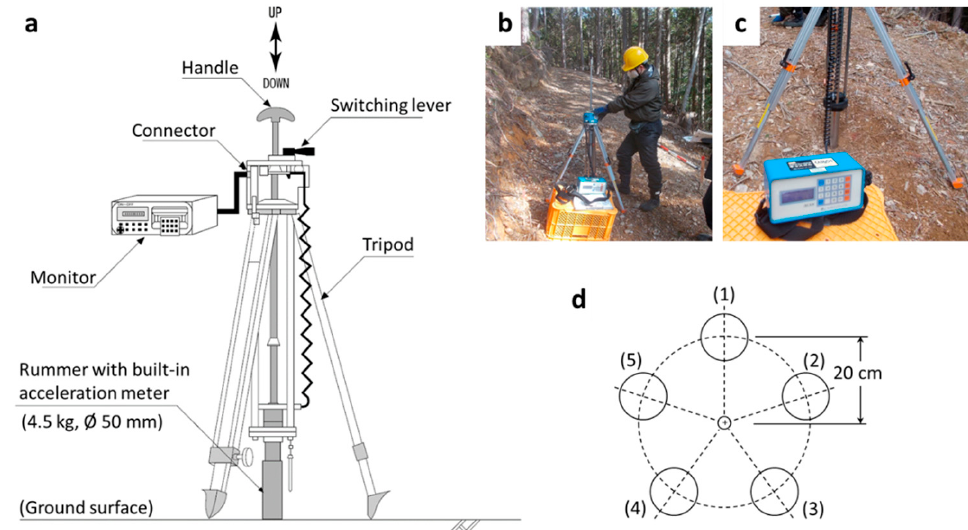
Figure 5. In-situ CBR measuring instrument (CASPFOL). Schematic diagram of CASPFOL ( a ) [51]. The acceleration of the rummer is measured by the instrument when the rummer falls and strikes the soil ( b, c ). The soil strength is measured by striking the rummer at a height of 500 mm with the road kept vertical through the built-in acceleration meter. The standard measuring method requires five measurements around a designated point with a 20 cm radius ( d ).